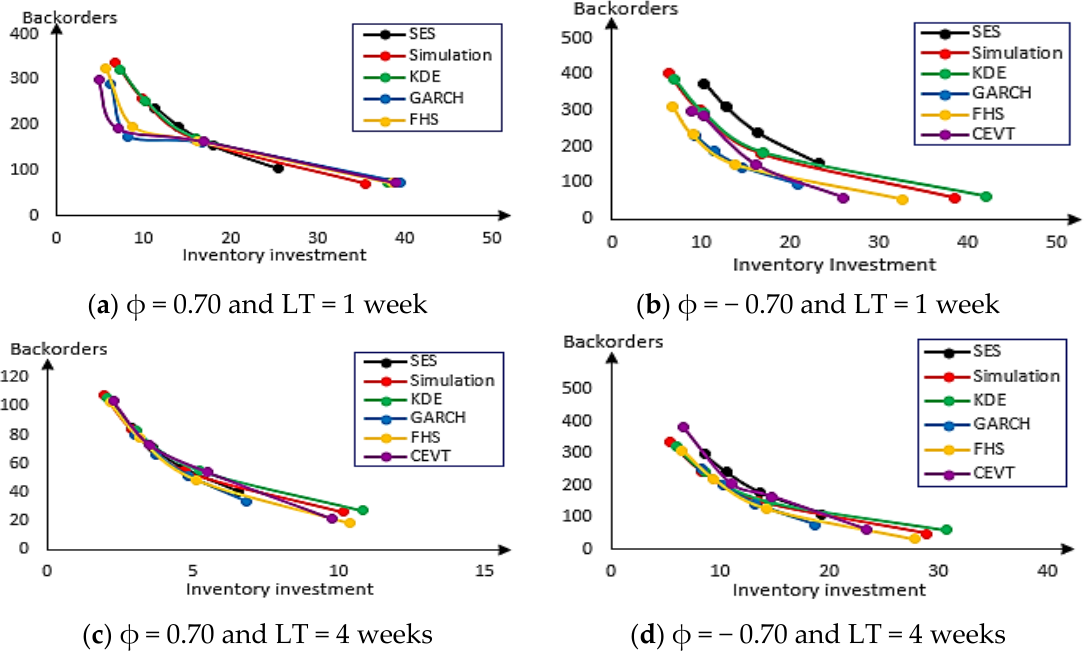
Figure 4. Tradeoff curves for AR (1) in the case of lognormal distribution for ϕ = 0.70 (a and c) and ϕ = − 0.70 (b and d) and lead times of one week ( a , b ) and four weeks ( c , d ).